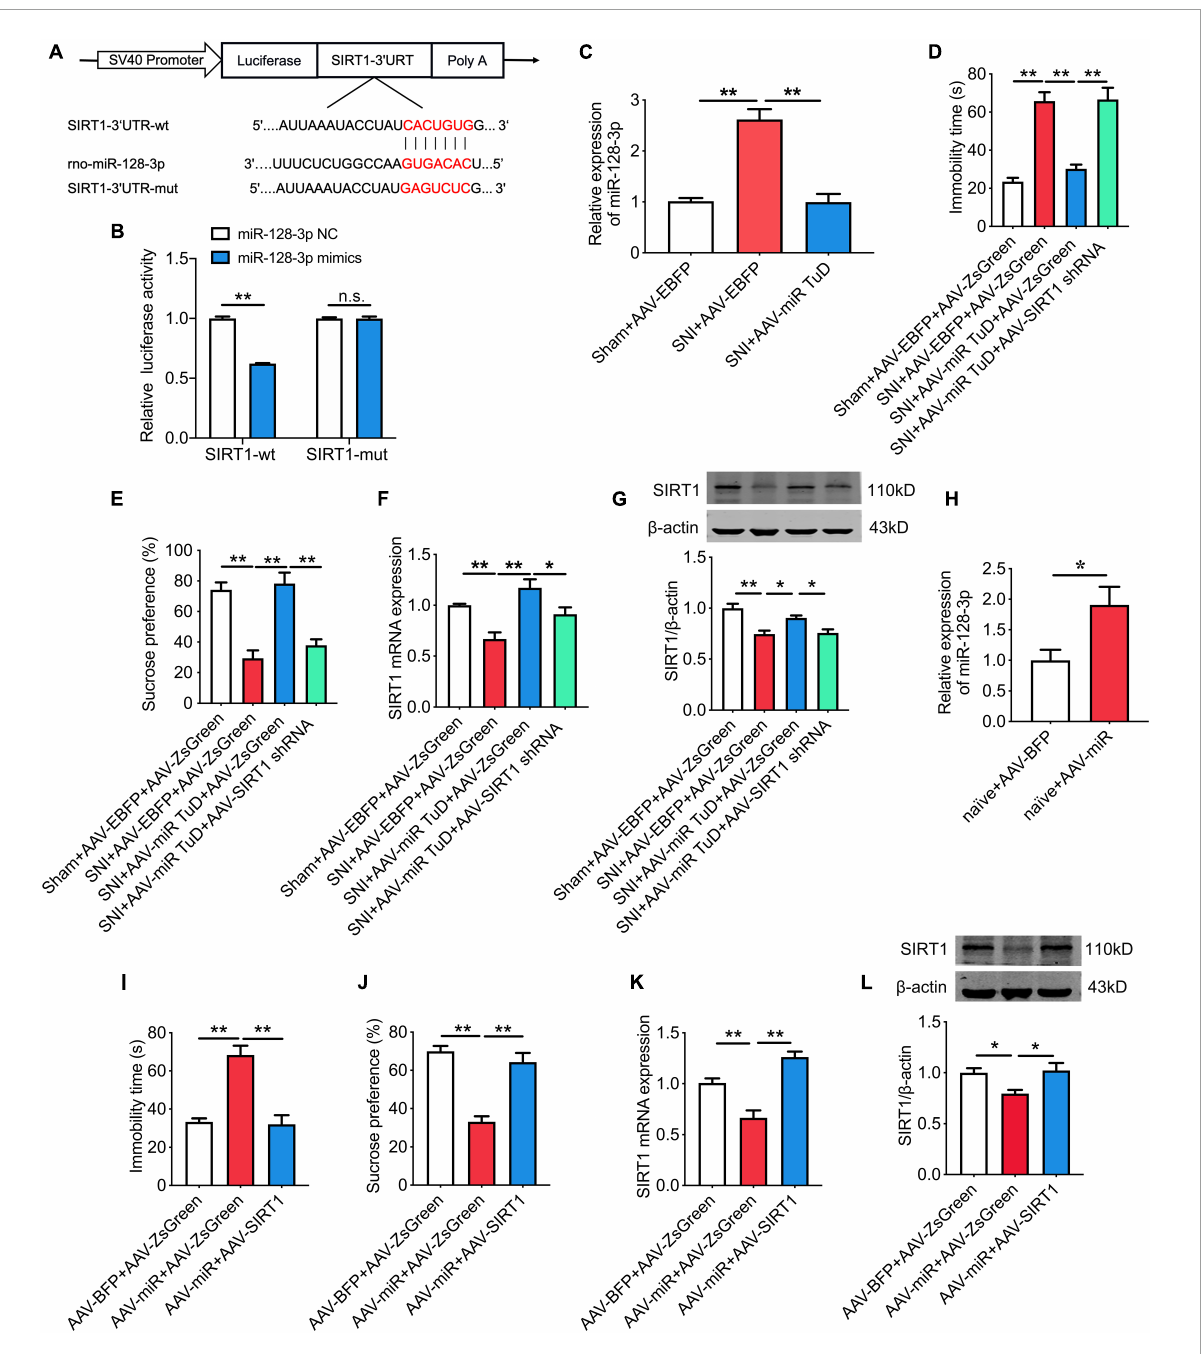
FIGURE6 SIRT1 is the downstream target of miR-128-3p and is involved in chronic pain-related depression. (A) The predicted potential binding sites of miR-128-3p to SIRT1 and schematic of wild-type (wt) and mutant-type (mut) of SIRT1. (B) Relative luciferase activity of wild type or mutated SIRT1 after co-transfection with miR-128-3p mimics ( n = 3). (C) Effect of intra-CeA infusion of AAV-miR-128-3p TuD on the level of miR-128-3p in SNI rats ( n = 8). (D,E) Effect of SIRT1 knockdown on miR-128-3p knockdown-mediated improvement of depression-like behaviors in SNI rats determined by the forced swim test (D) and the sucrose preference test (E) ( n = 8). (F,G) Effect of SIRT1 knockdown on miR-128-3p knockdown-mediated increase of SIRT1 mRNA (F) and protein (G) expressions ( n = 8). (H) Effect of intra-CeA infusion of AAV-miR-128-3p on the level of miR-128-3p in naïve rats ( n = 8). (I,J) Effects of SIRT1 overexpression on miR-128-3p overexpression-mediated depression-like behaviors in naïve rats determined by the forced swim test (I) and the sucrose preference test (J) ( n = 8). (K,L) Effect of SIRT1 overexpression on miR-128-3p overexpression-mediated decrease of SIRT1 mRNA (K) and protein (L) expressions ( n = 6–8). All data are expressed as the mean ± SEM. * P < 0.05, ** P < 0.01. n.s., not